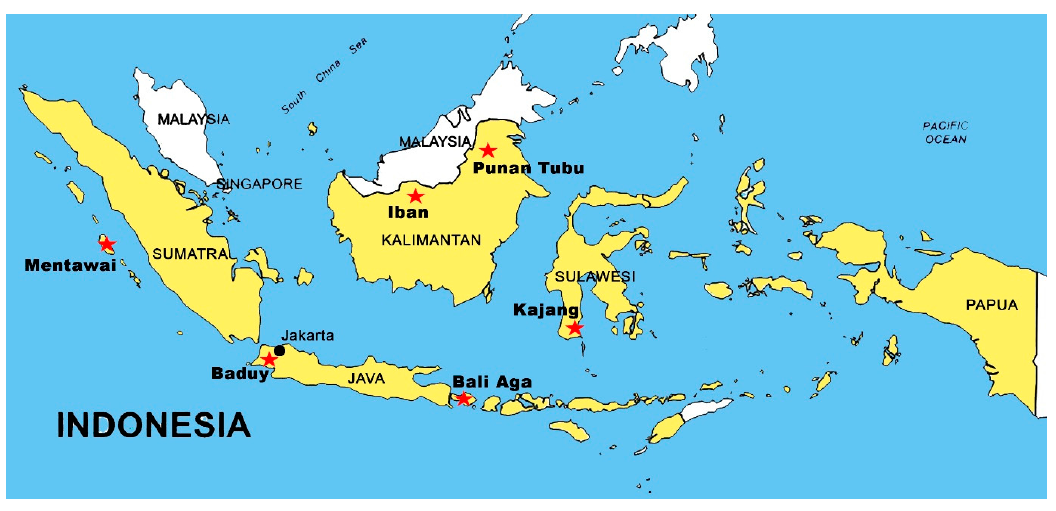
Figure 1 . Locations of the adat communities discussed. Figure 1. Locations of the adat communities